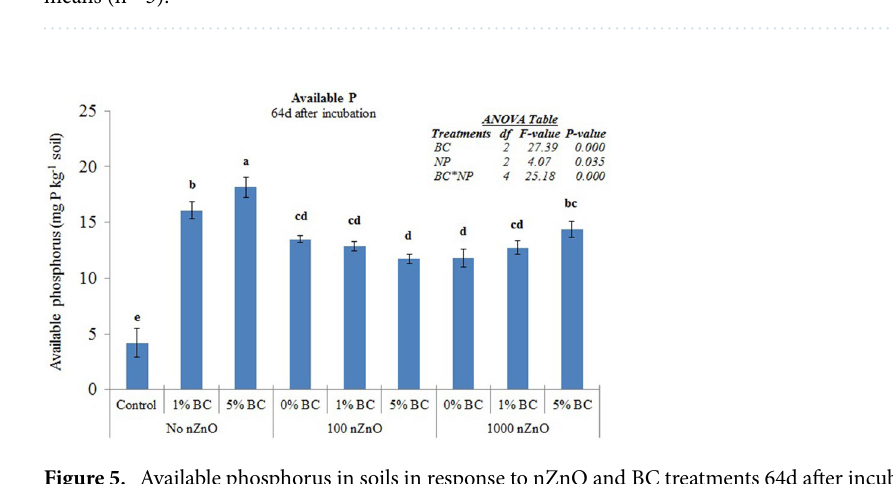
Figure 5. Available phosphorus in soils in response to nZnO and BC treatments 64d after incubation. Different small letters on top of bars represent post-hoc HSD difference at 95% confidence interval. Error bars represent standard errors of means (n = 3).